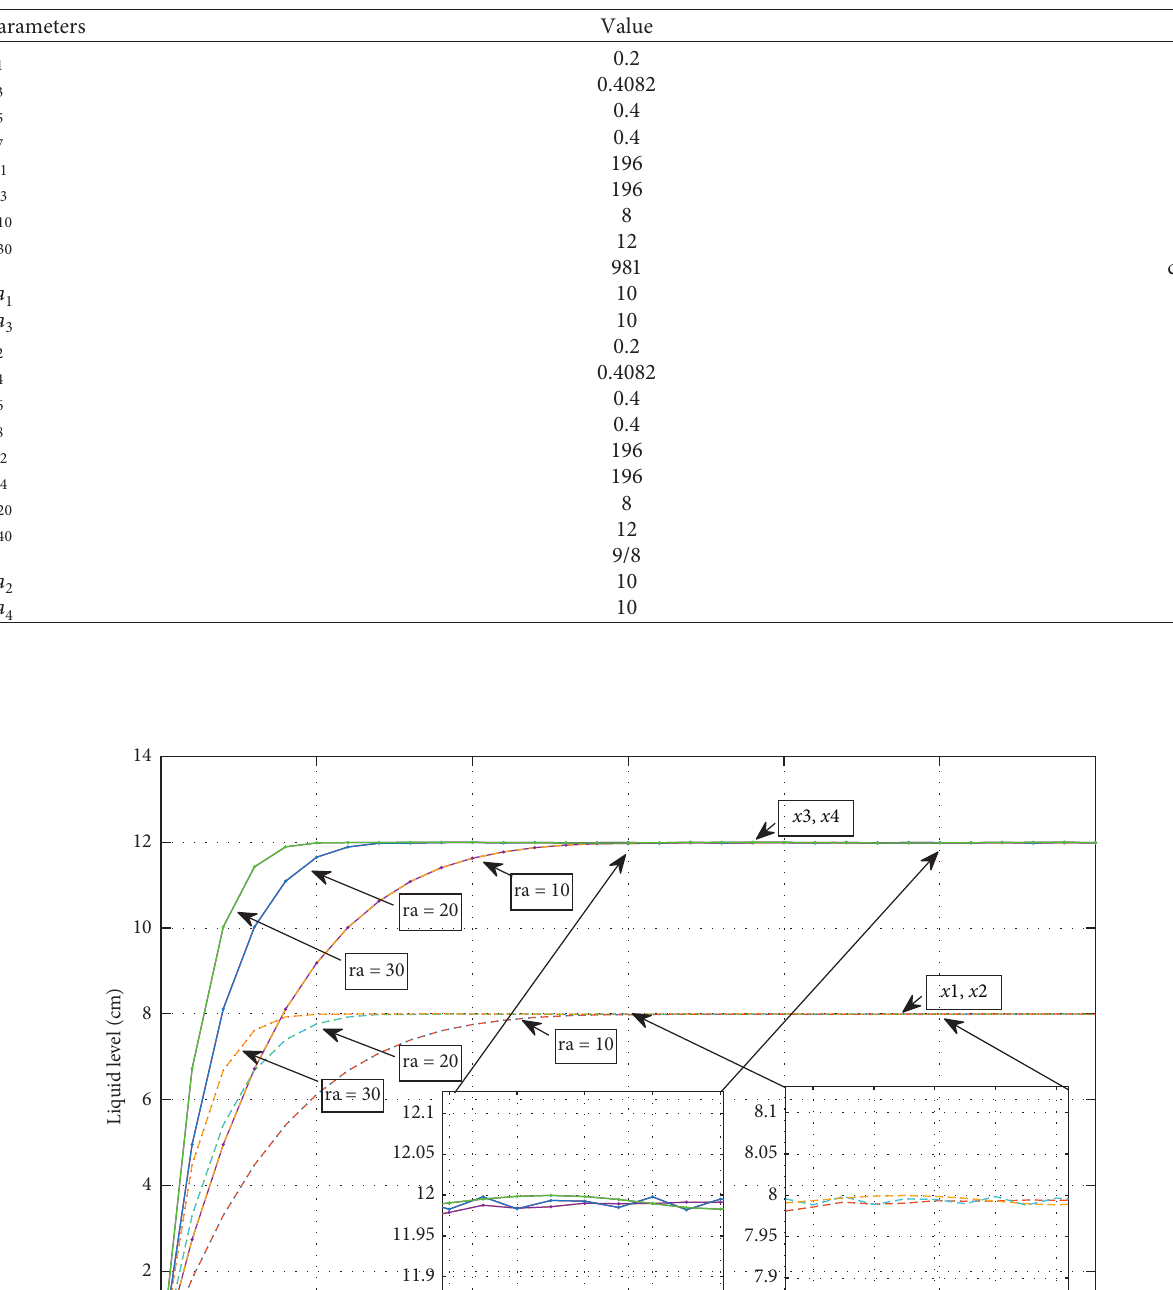
Table 1: Parameters of the simulation.